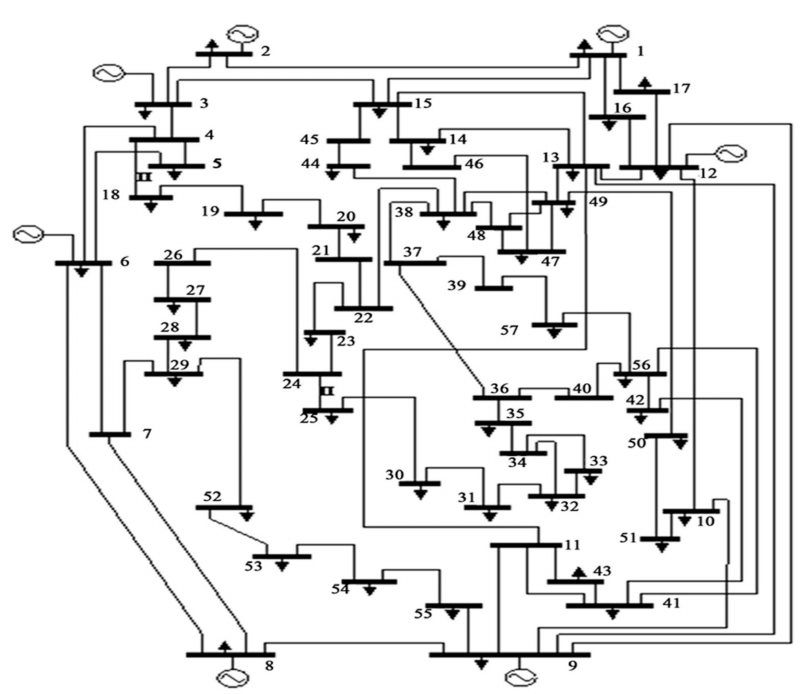
Figure A1. Single line diagram of the IEEE 57-Bus test